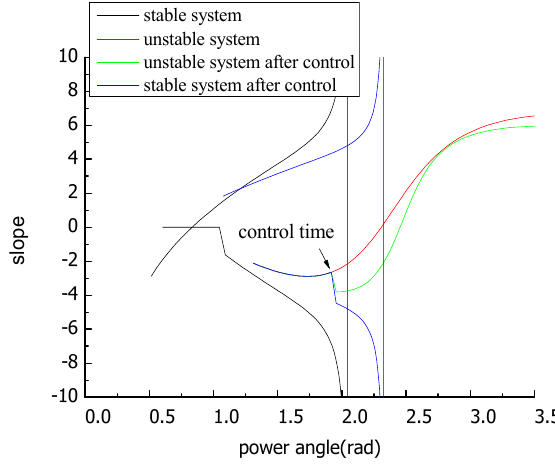
Figure 5. The slope over power angle.